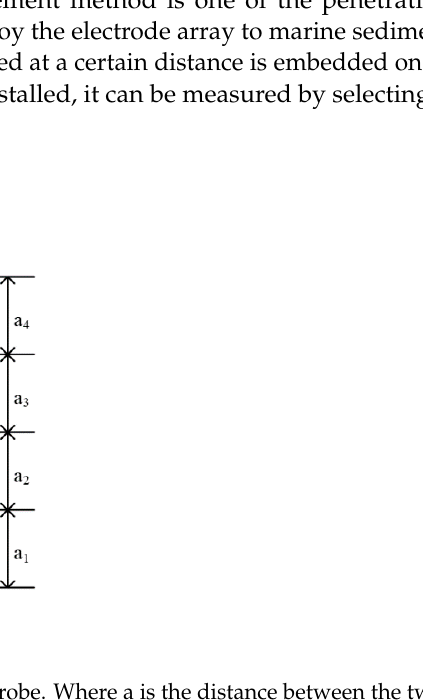
Figure 8. Analysis diagram of the probe penetration process.